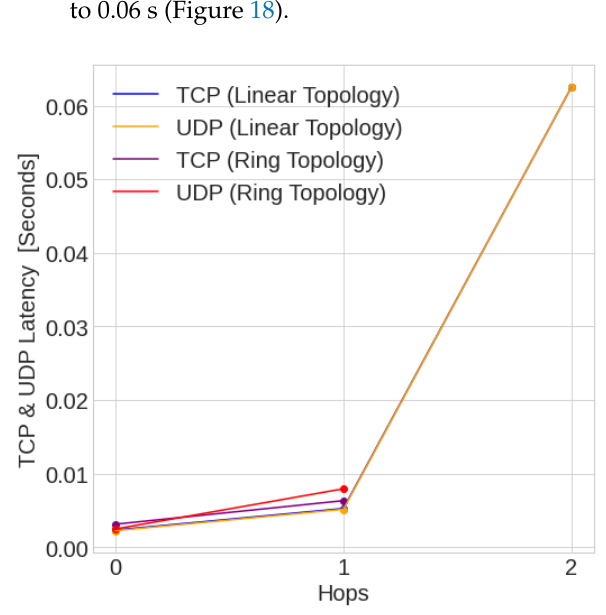
Figure 18. POWDER lab TCP and UDP